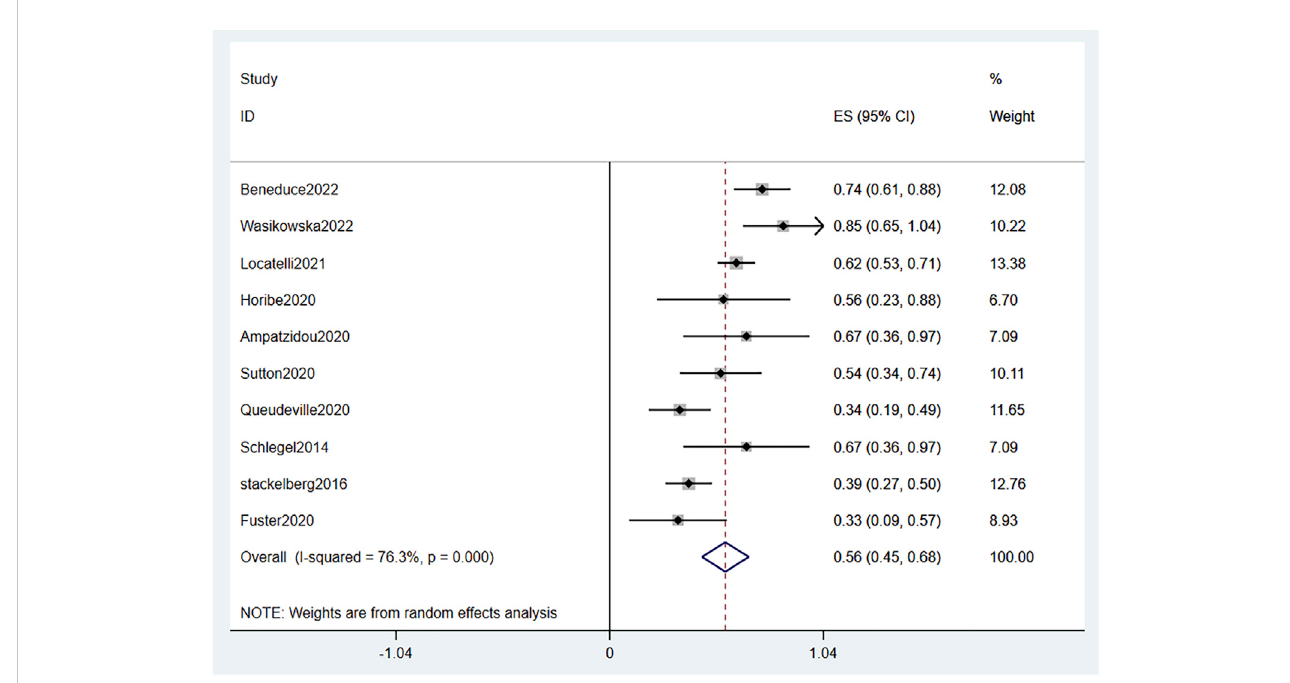
FIGURE 2 Forest plot of CR. CR, complete response; 95% CI, 95% con fi dence interval; ES: Effect Size. The size of the rectangle at the center of the horizontal bar is proportional to the weight of the given study. The diamond at the bottom indicates the pooled ES (only single-arm studies have CR